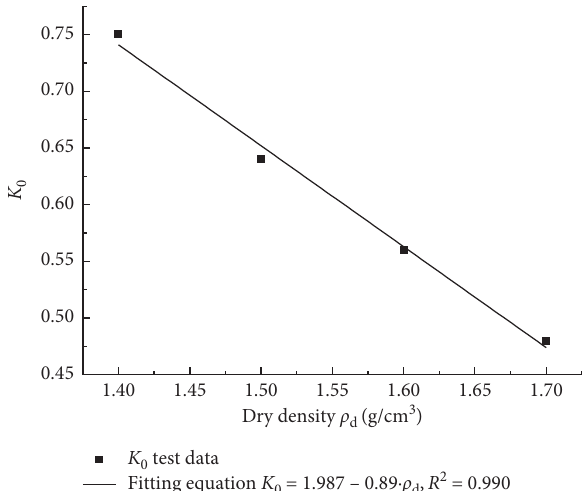
Figure 9: Relationship between the K density.